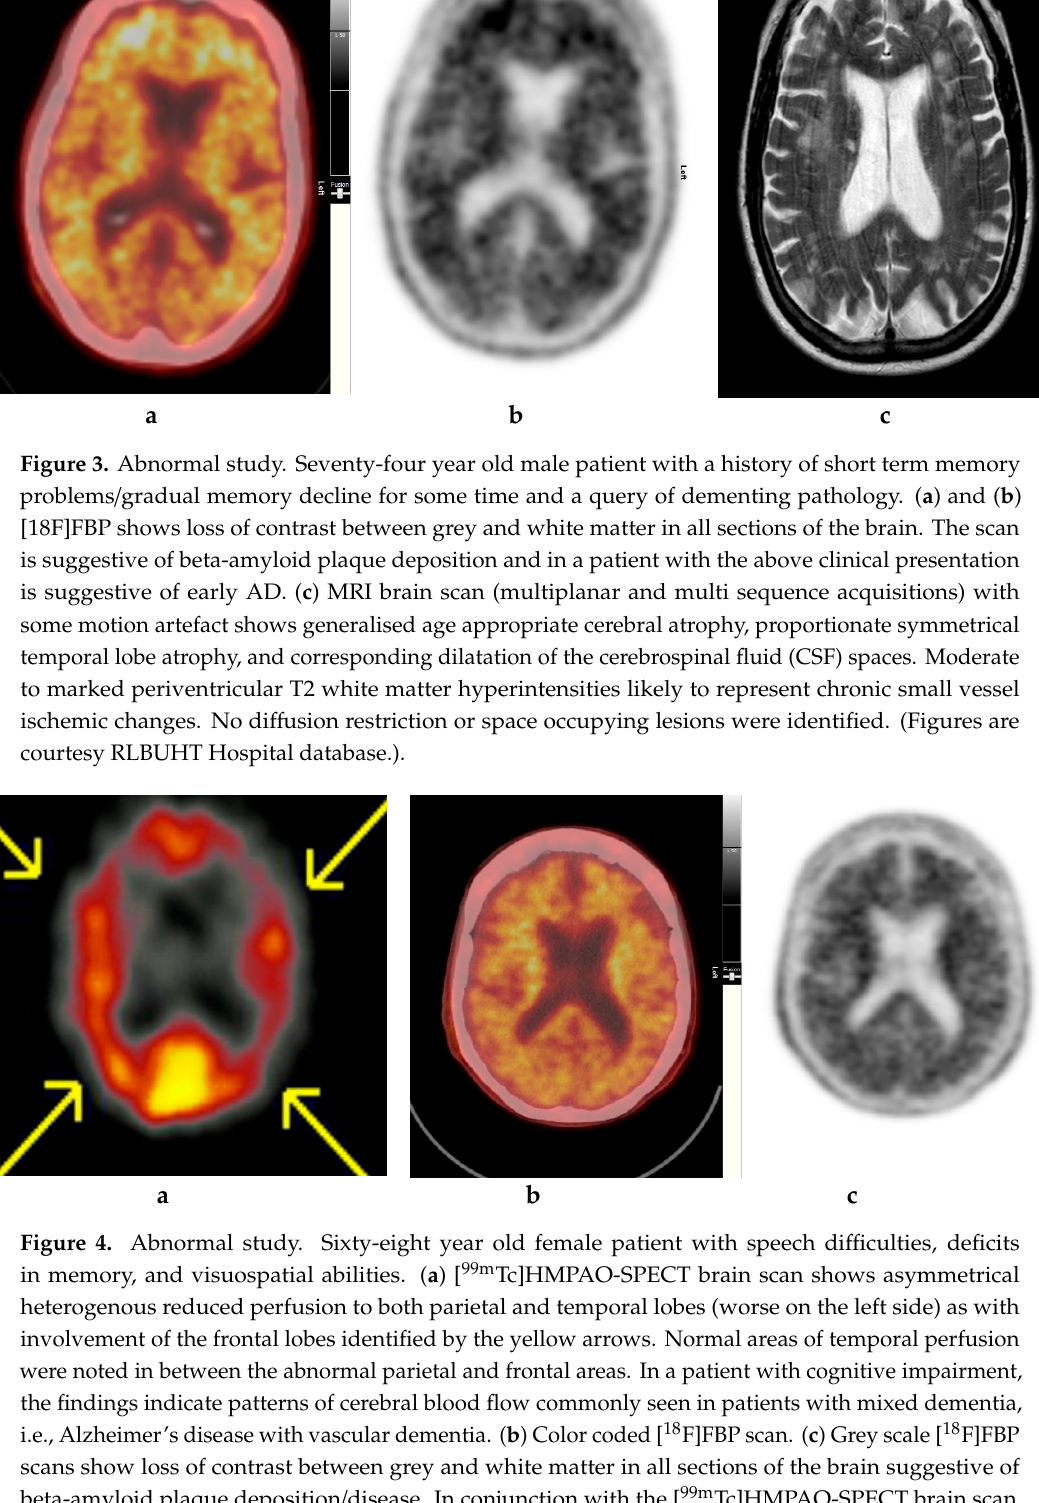
beta-amyloid plaque deposition / disease. In conjunction with the [ 99m Tc]HMPAO-SPECT brain scan,